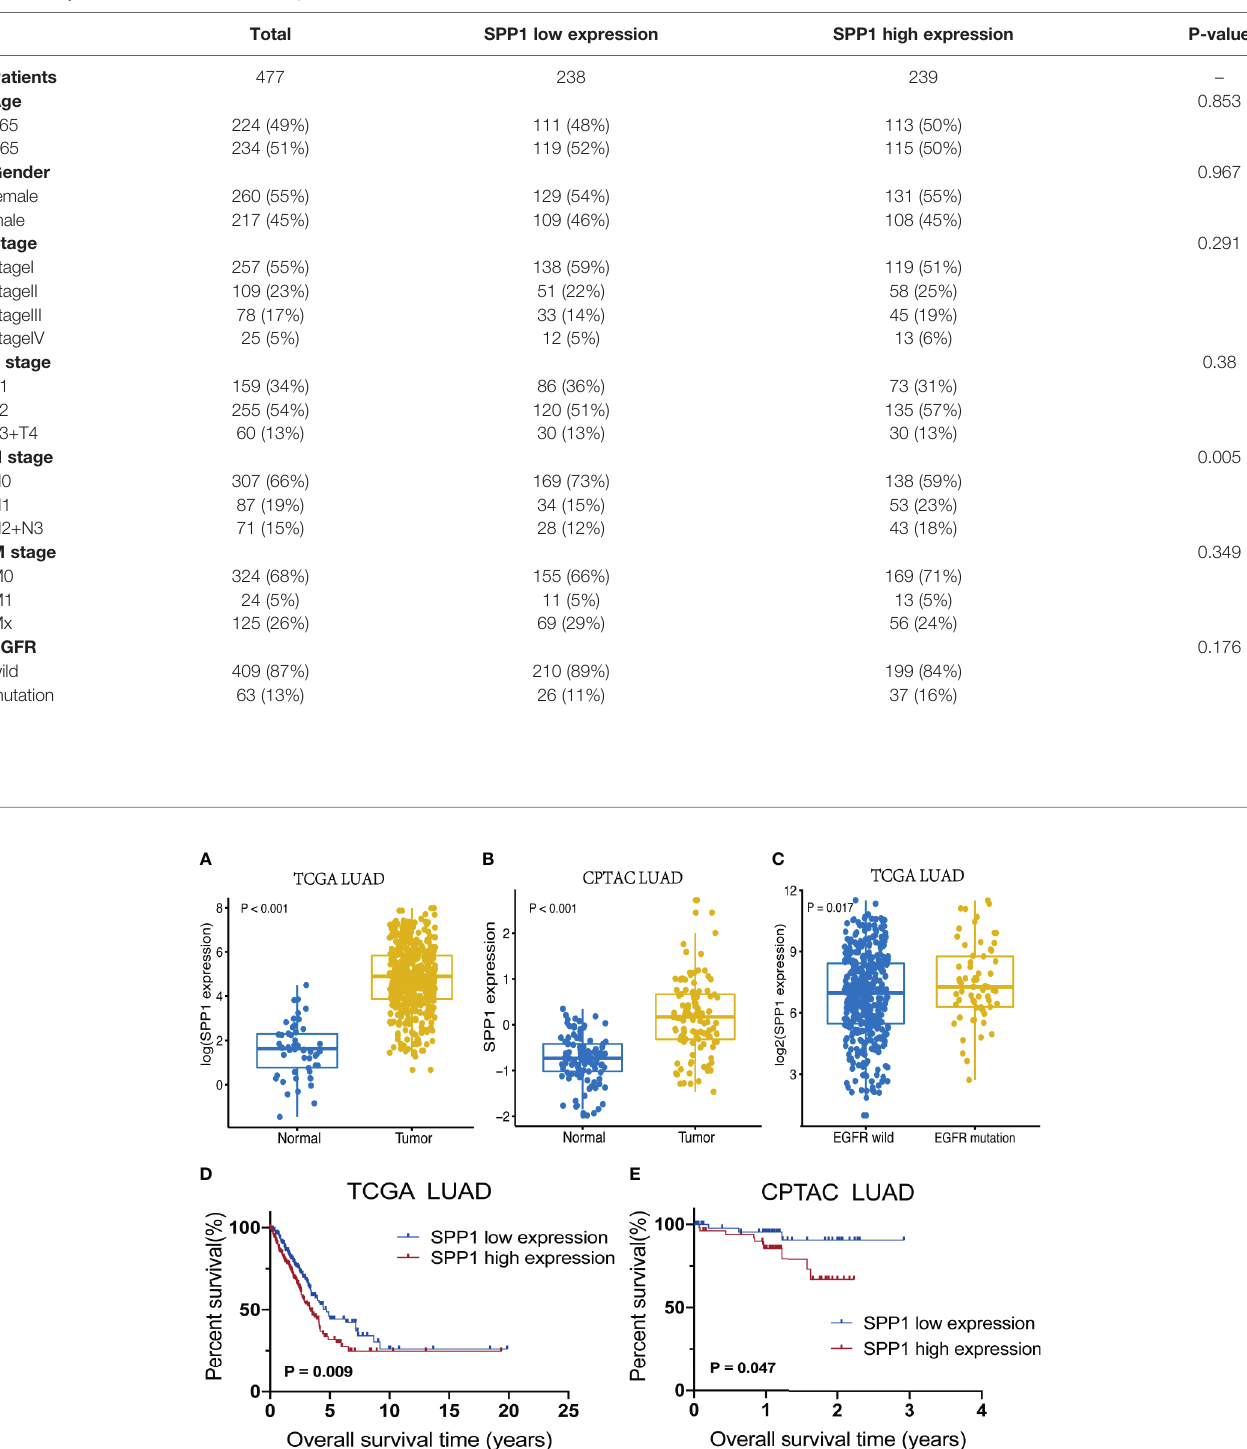
TABLE 1 | The clinical characteristics of patients in